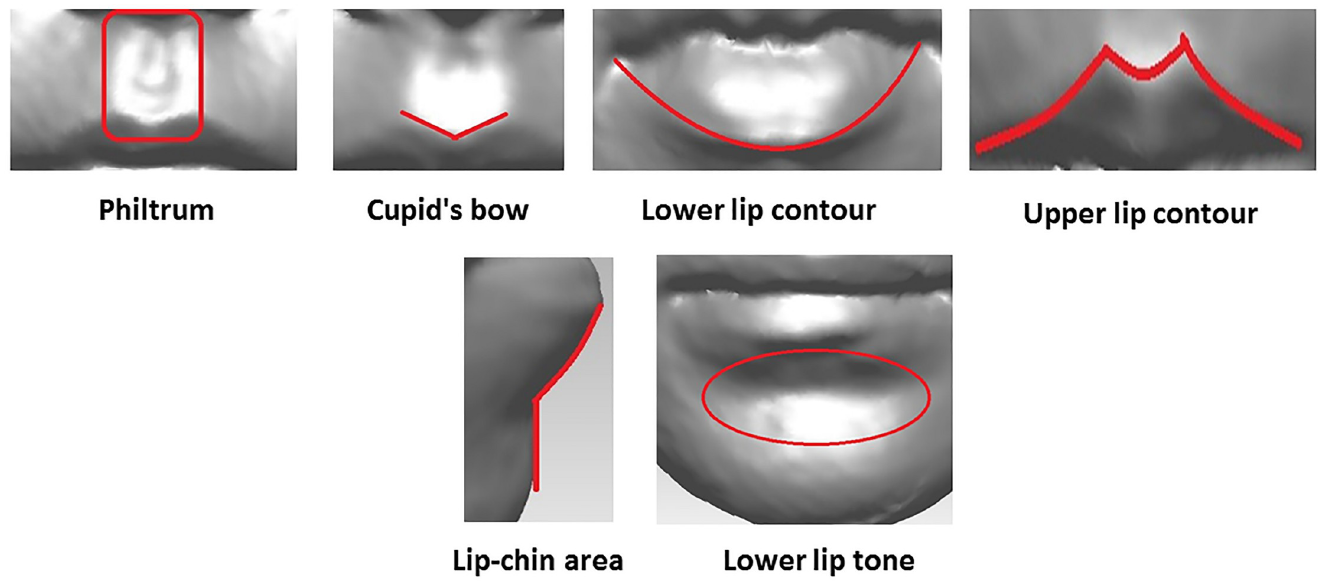
Fig 2. Lip traits. Description of the lip traits used in the present study.